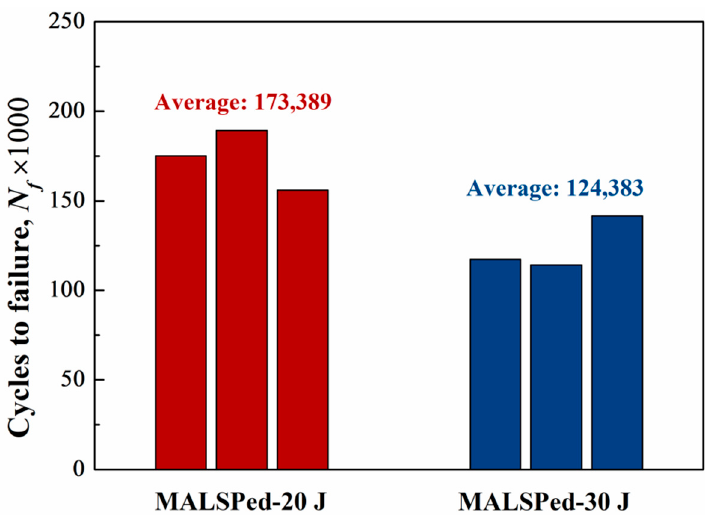
Figure 11. Three-point bending fatigue properties of MATLSPed-20 J and MATLSPed-30 J speci- mens.